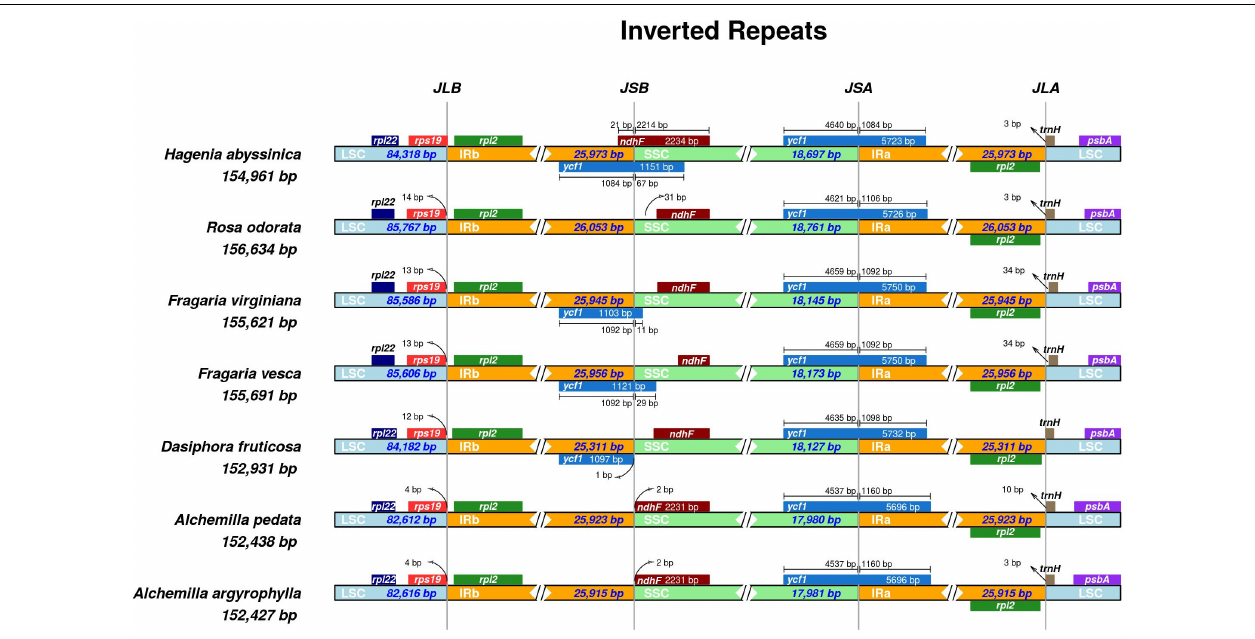
FIGURE 4 | Comparative distance between the boundaries of the two inverted repeats (IRa/IRb), small single copy (SSC), and large single copy (LSC) regions and adjacent genes among the chloroplast genomes of seven Rosaceae species using IRscope software (Amiryousefi et al., 2018). The species name and their corresponding genome lengths are shown on the left side of the figure. JLB, JSB, JSA, and JLA correspond to LSC/IRb, IRb/SSC, SSC/IRa, and IRa/LSC junctions, respectively. Genes drawn above the track indicate direct transcription, and genes below the track indicate complement transcription. The arrows indicate the distance from the beginning or ending coordinate of the specific gene from the corresponding junction; AT bar above or below the gene extending into two regions shows to what extent in base pairs it has stretched. The figure is not drawn to scale based on sequence length but only shows the relative change near or at the IR/SC